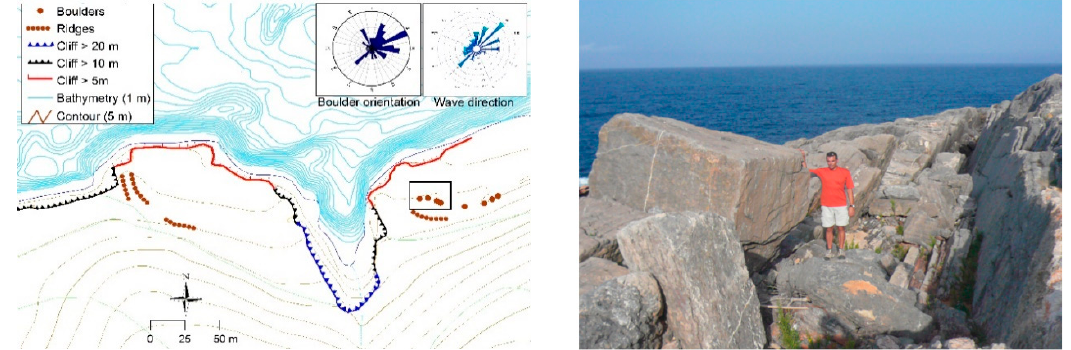
Figure 8. Geomorphological scheme of the Pou des Lleó area. Roses show the dominant orientation of boulders (picture on the right) and the prevailing waves.